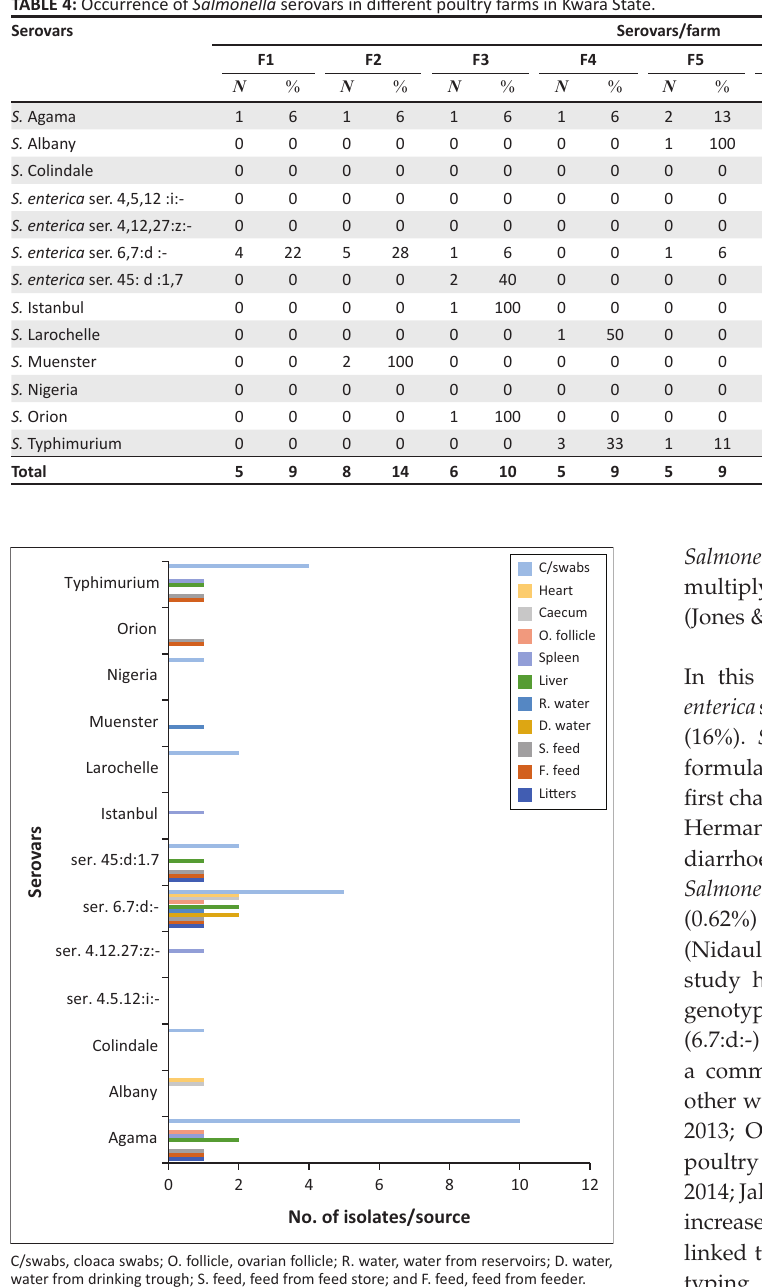
FIGURE 2: Frequency of Salmonella serovars isolated from different